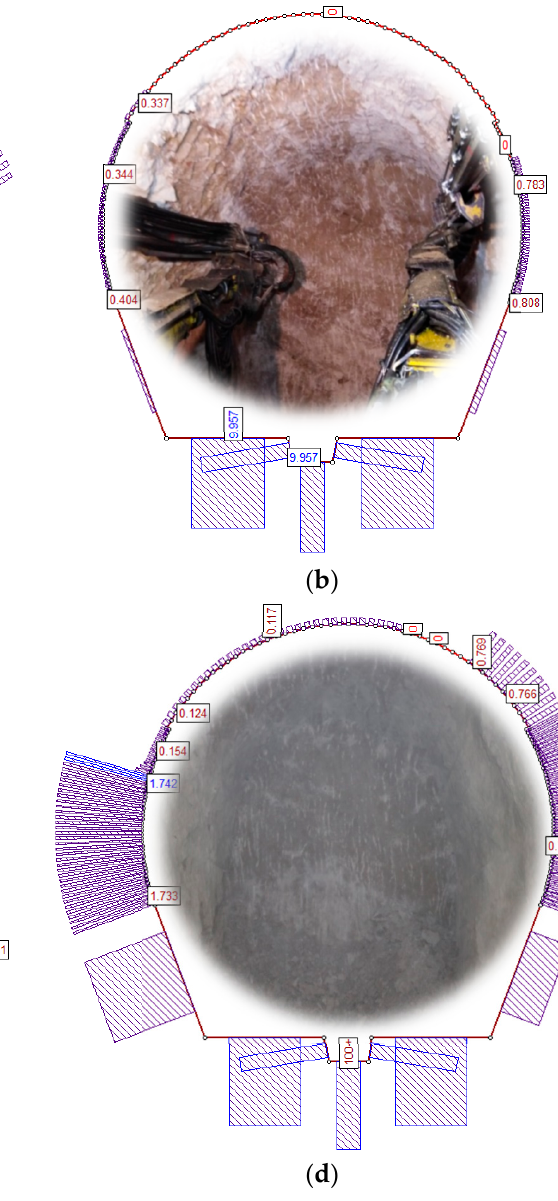
Figure 9. Results of probabilistic analysis at two selected sections: km 7 + 066.00 and km 8 + 514.50. ( a , c ) Probability of failure of different segments around tunnel contour; ( b , d ) probabilistic safety factor value around tunnel contour. Table 2. Results of probabilistic analysis at CH 7 + 066 and CH 8 + 514.5.